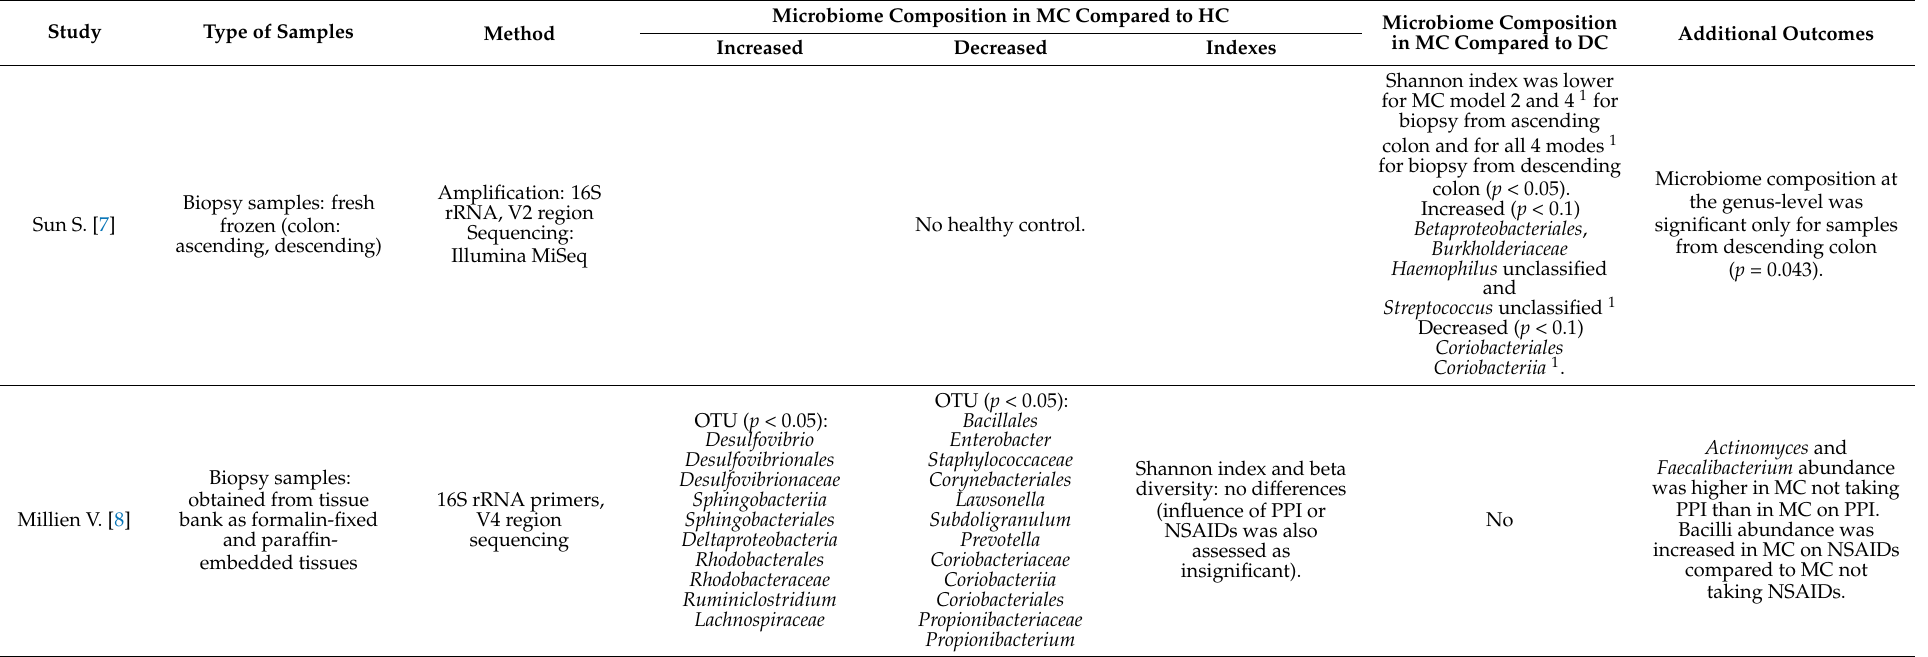
Table 4. Results of the microbiome assessment in patients with microscopic